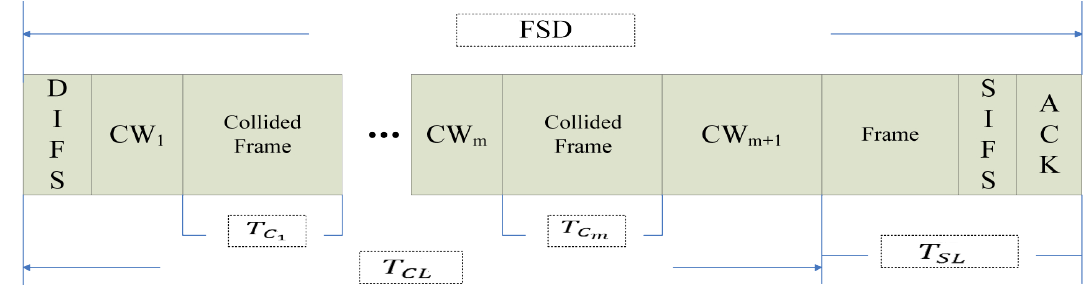
Figure 2. The delay of the basic access